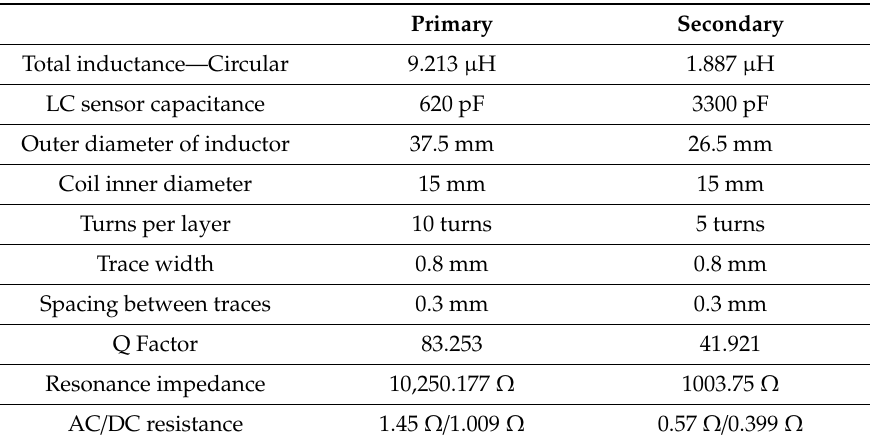
Table 2. PCB Coil Parameter